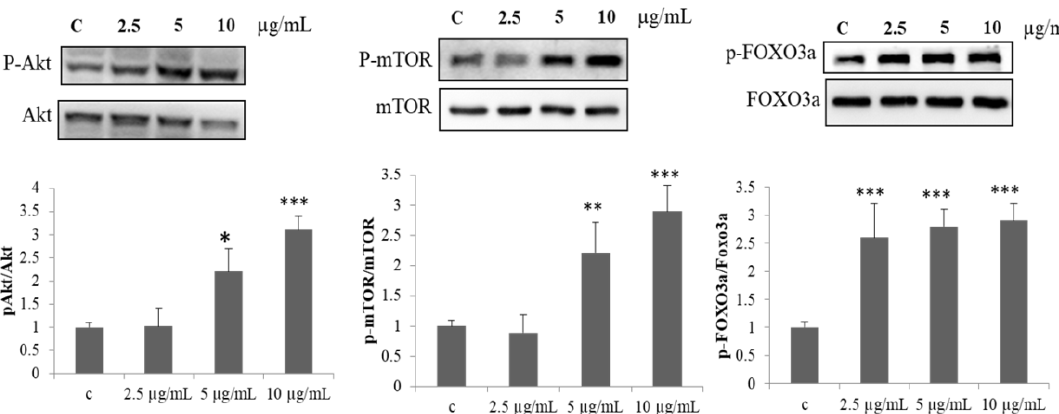
Figure 2. PPH902 enhances protein synthesis mechanism. Representative Western blotting shows phosphorylation of Akt and FOXO3A in C2C12 cells in response to PPH902 administration. *** p < 0.001, ** p < 0.01 and * p < 0.05 indicate significant differences with respect to control group.